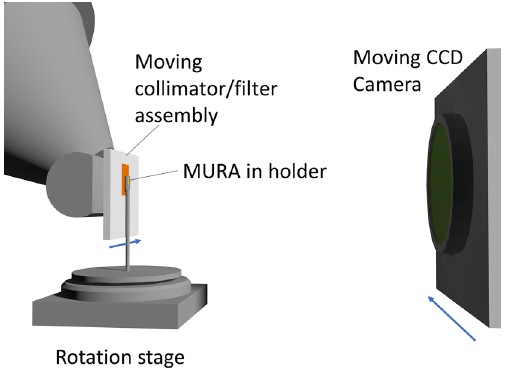
Figure 1. MuCAT 2 micro-CT scanner arrangement with the MURA